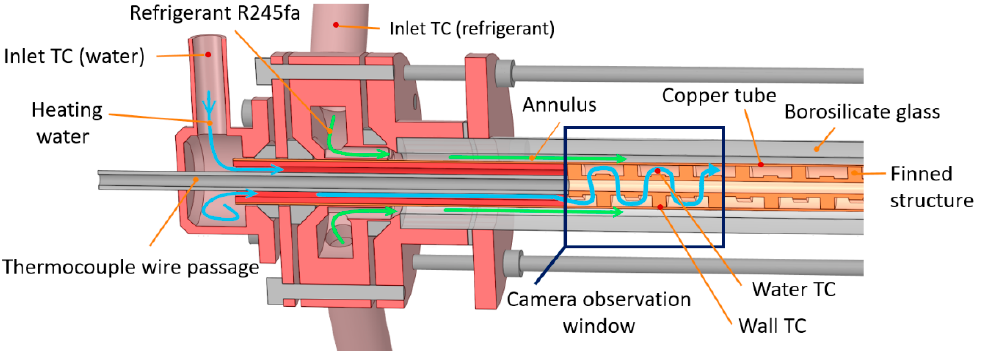
Figure 2. Cross-section and schematic of the test section (zoom-in of the inlet part). The location of both inlet thermocouples in the inlet tubes is approximate as they are located further on the inlet lines.